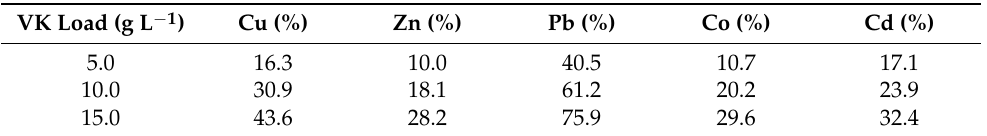
Figure 2. Raw VK adsorption studies using 5 g L − 1 clay loading for ( a ) C 0 = 200 mg L − 1 for 10 to 180 min and ( b ) C 0 = 100 to 500 mg L − 1 at 90 min. Table 2. Effect of raw VK loading variation ( C 0 = 200 mg L − 1 at 90 min) on the percentage removal (%) of divalent